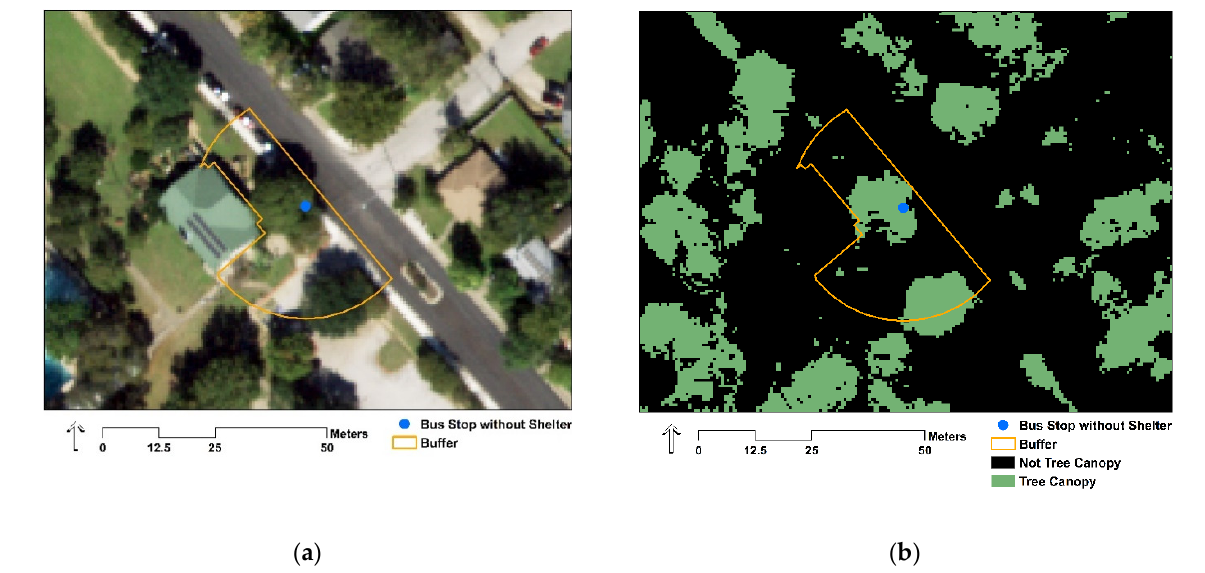
Figure 2. ( a ) Buffer to calculate the percentage of tree canopy surrounding a bus stop (aerial image); ( b ) buffer to calculate the percentage of tree canopy surrounding a bus stop (Not Tree Canopy and Tree Canopy classes).